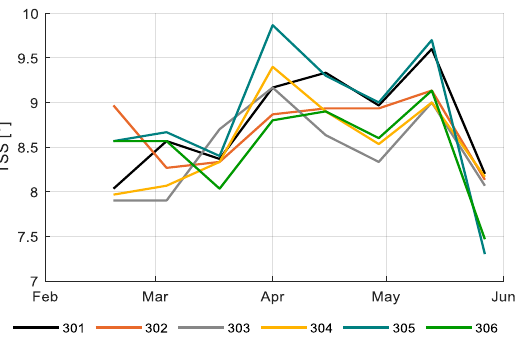
Figure 17. Brix of tomato fruits ( o ) in different greenhouse compartments (301–306).